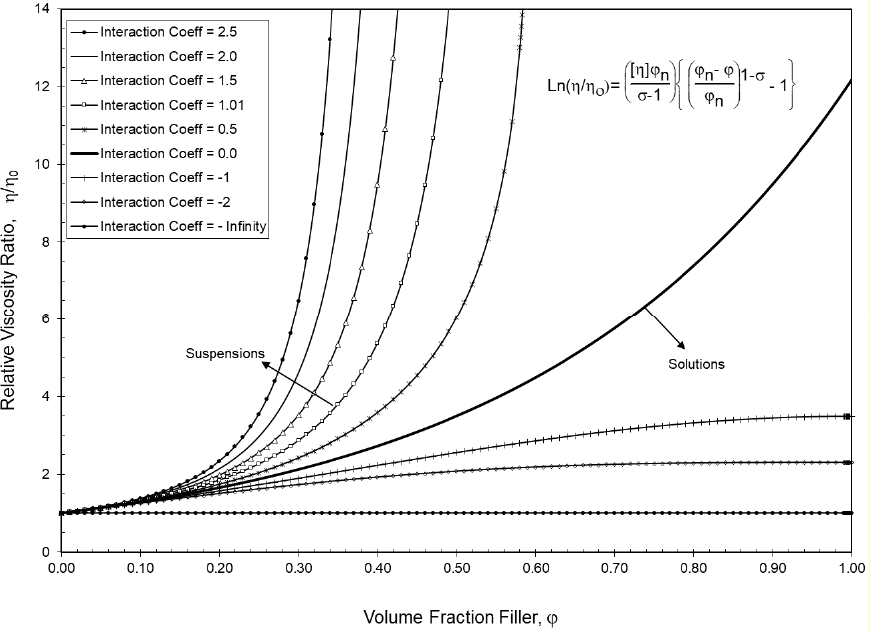
Figure 6. General viscosity model vs. volume fraction filler for a range of interaction coefficients. ([ η ] = 2.5 and ϕ n =